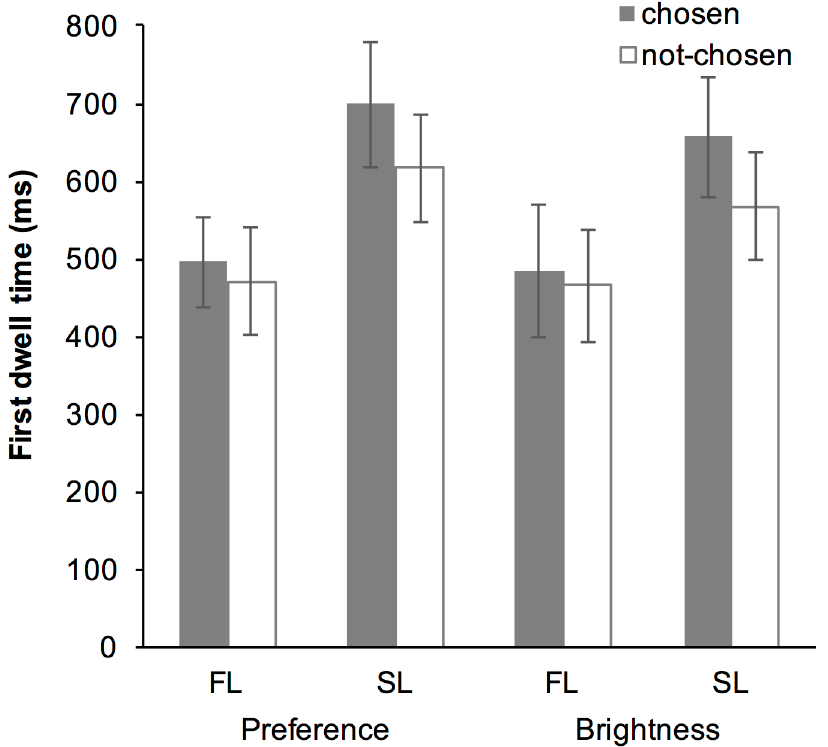
Fig 5. Averaged first dwell time in the wine block in Experiment 2. Error bars representthe standard error of the mean.